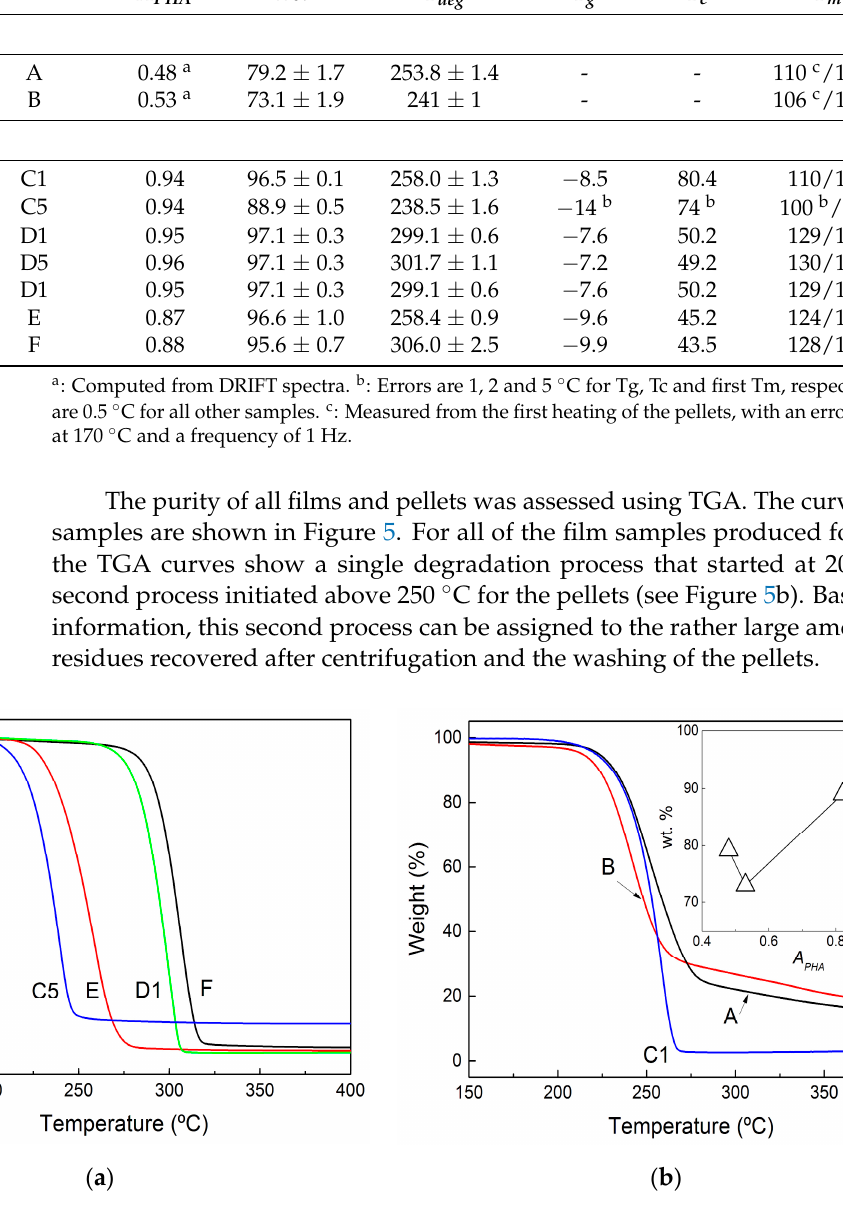
Table 2. Samples produced from the downstreaming of corresponding biomasses with parameter n , with their purities quantified by FTIR ( A PHA ) and TGA (wt%) as well as their melt properties (temperatures T deg , T g , T c and T m in °C, and dynamic shear viscosity | η *| in Pa.s).